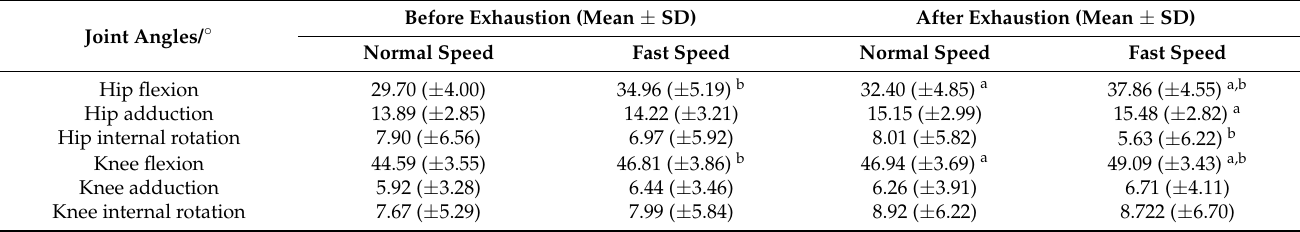
Table 2. Peak joint angles for different speeds for pre- and post-conditions.